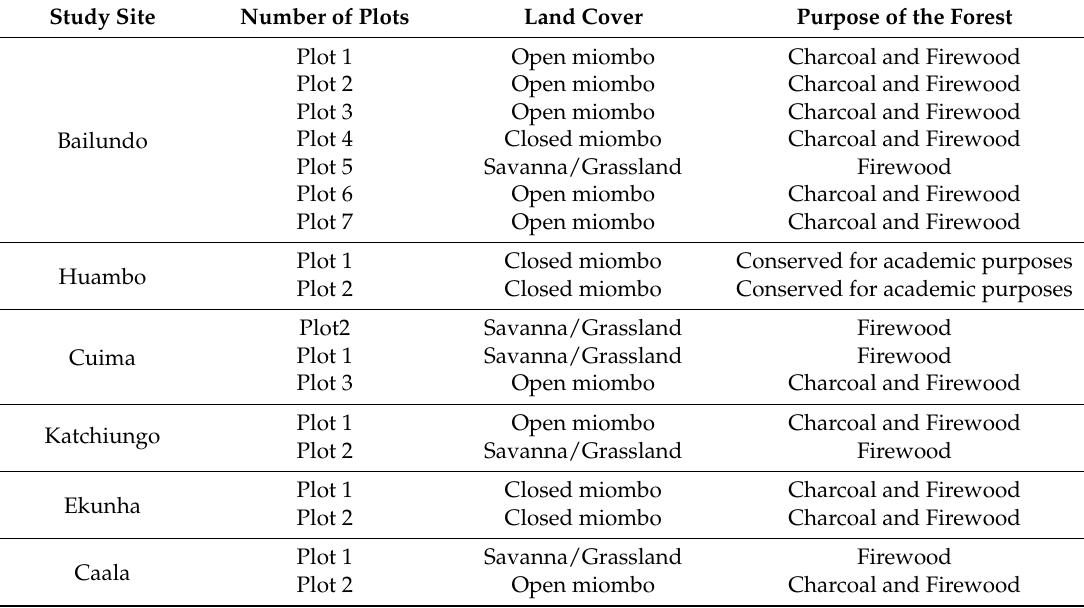
Table A1. Number of Plots Sampled in Each Land